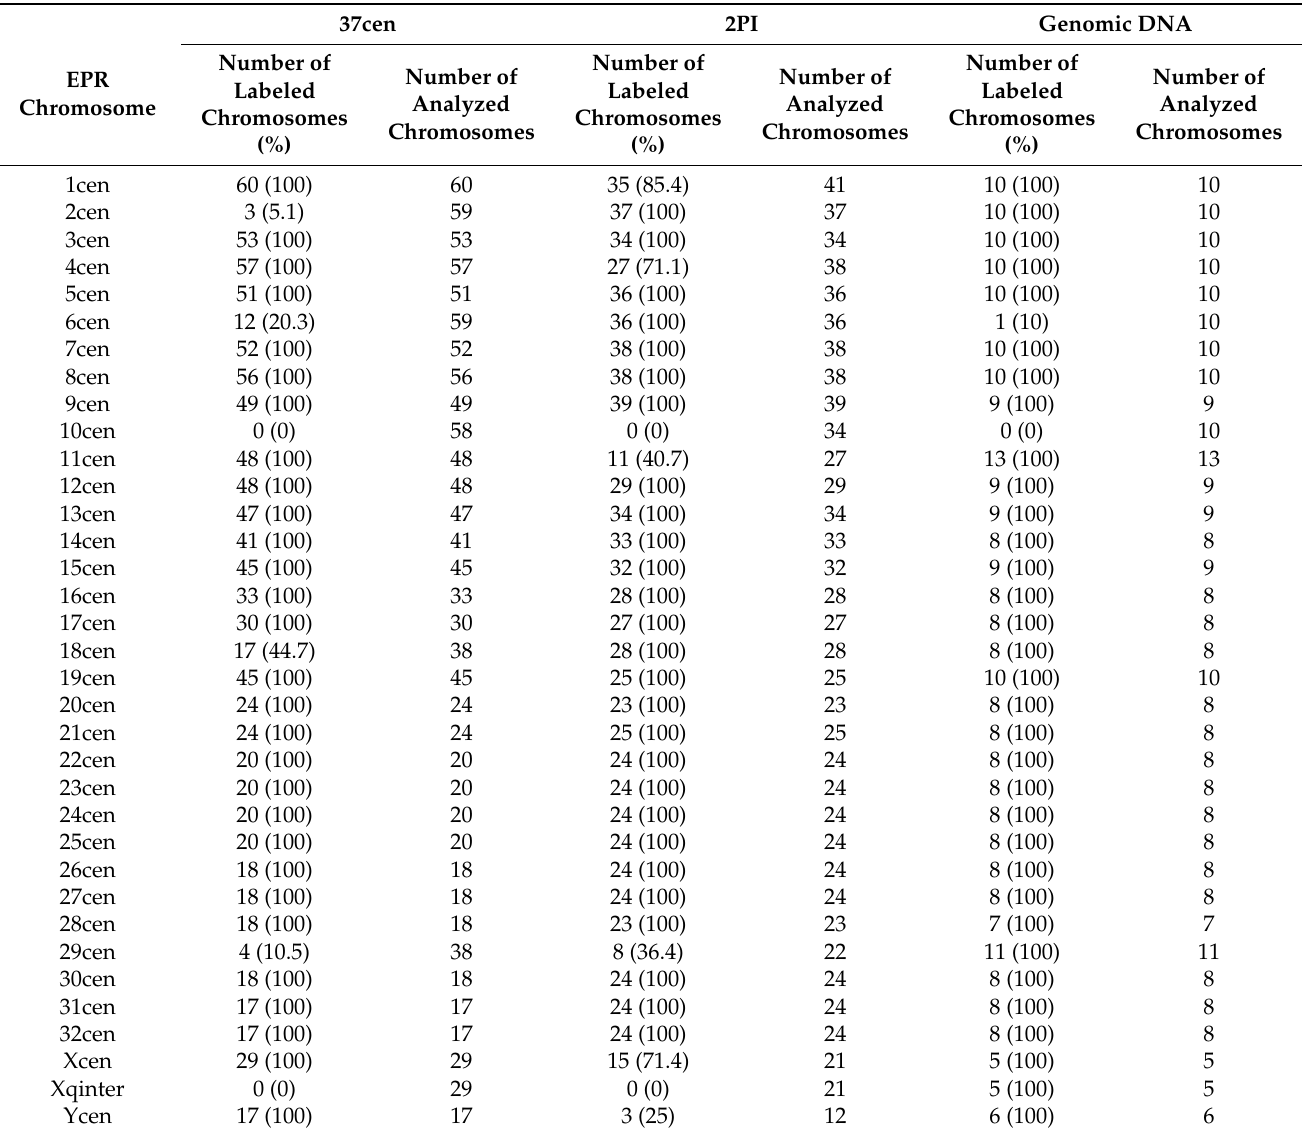
Table 1. Distribution of satellite DNA families on Equus przewalskii